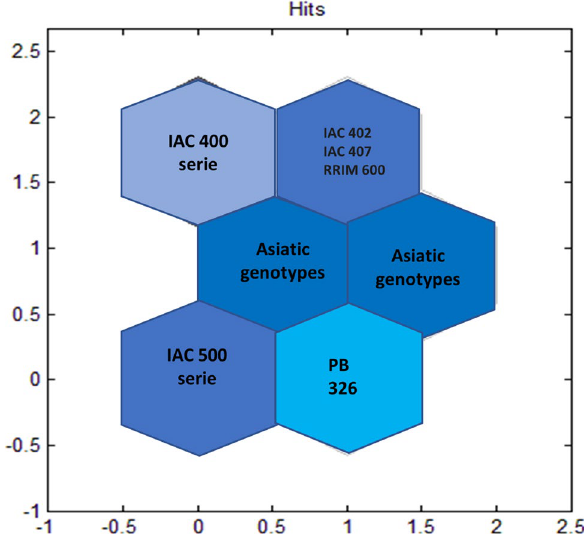
Figure 4. For self-organizing maps (SOMs), six clusters were formed. From left to right and from bottom to top: Cluster I comprises the IAC 500 series; cluster II comprises PB 326; cluster III comprises IAC 507 and